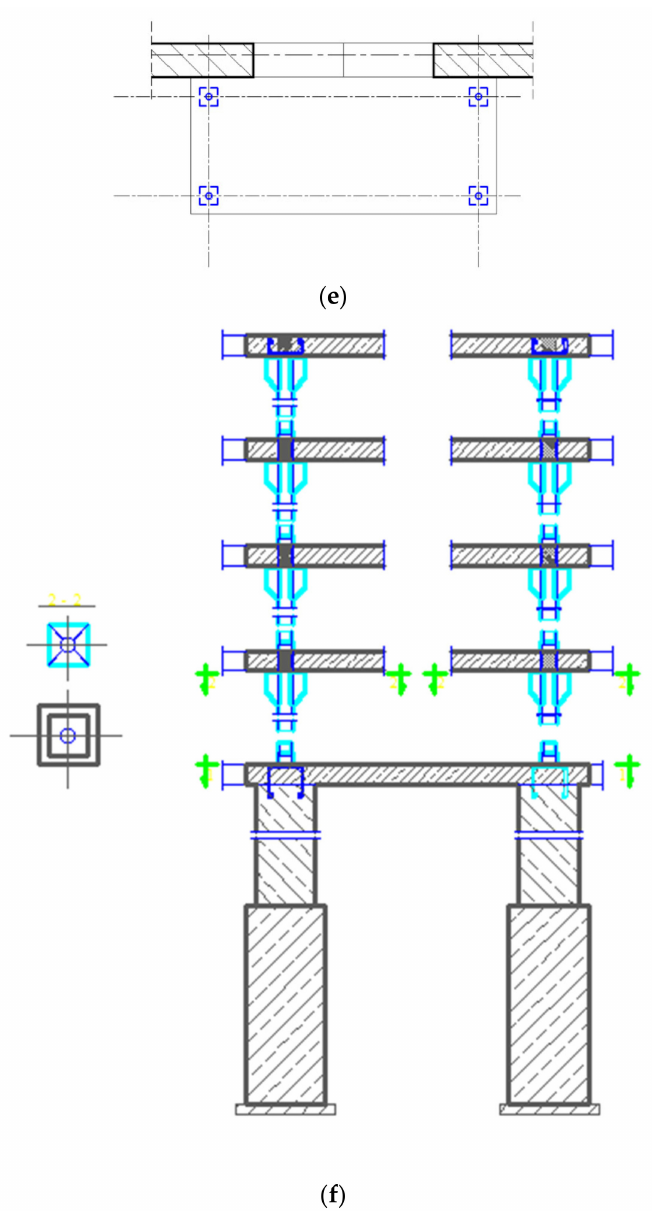
Figure 3. Various methods of thermal modernization of cantilevered balcony slabs, ( a ) scenario I; ( b ) scenario II; ( c ) scenario III; ( d ) scenario IV—cross section (author’s archive); ( e ) scenario IV—floor plan (author’s archive); ( f ) scenario IV—section (author’s